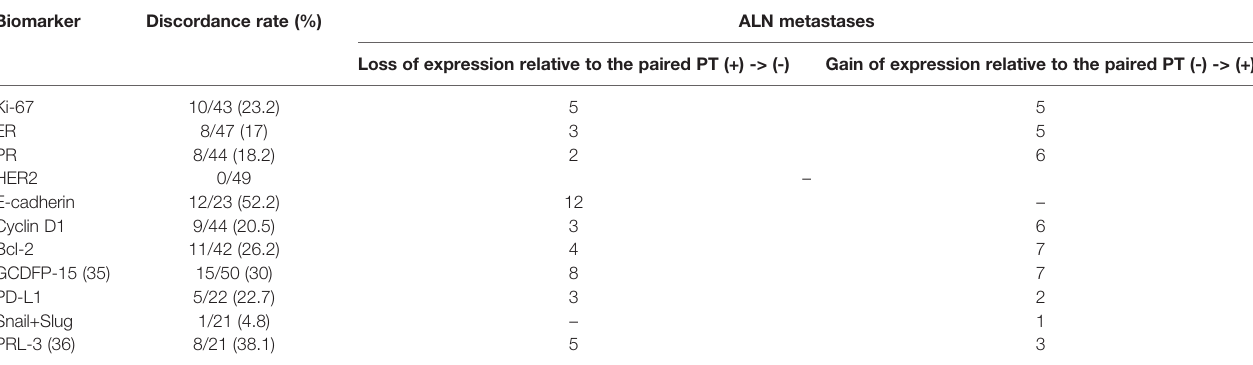
TABLE 6 | Discordance of the expression status of the biomarkers between breast PTs and synchronous ALN metastases. Biomarker